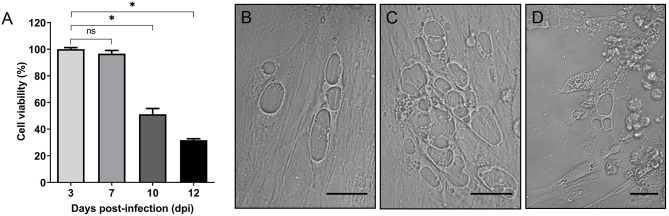
In vitro infection of SHK-1 cells. (A) Cells were infected with P. salmonis at a multiplicity of infection (MOI) of 100. Cell viability was analyzed by alamarBlue assay at different days post-infection (dpi). Data reflect means ± SD (N = 12 biological replicates); asterisks above the bars indicate significant differences (p < 0.05), ns, no significant differences. Data were analyzed with GraphPad Prism V8.0.1 using an unpaired t-test with Welch's correction. (B–D) Representative images of bright-field microscopy of SHK-1 cells at different days post-infection. (B) 7 dpi, (C) 10 dpi, (D) 12 dpi. Bar = 10 μm.